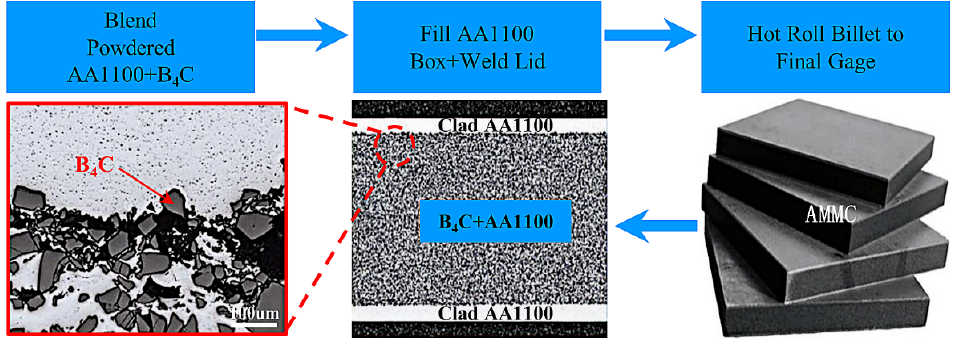
Figure 8. AMMC manufacturing processes [45].